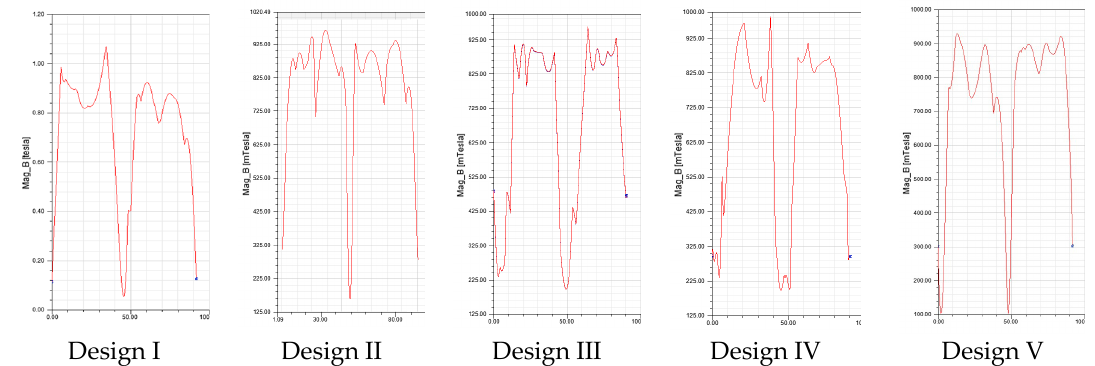
Figure 11. Flux density distributions for ¼ machine (for 90 mechanical degrees).